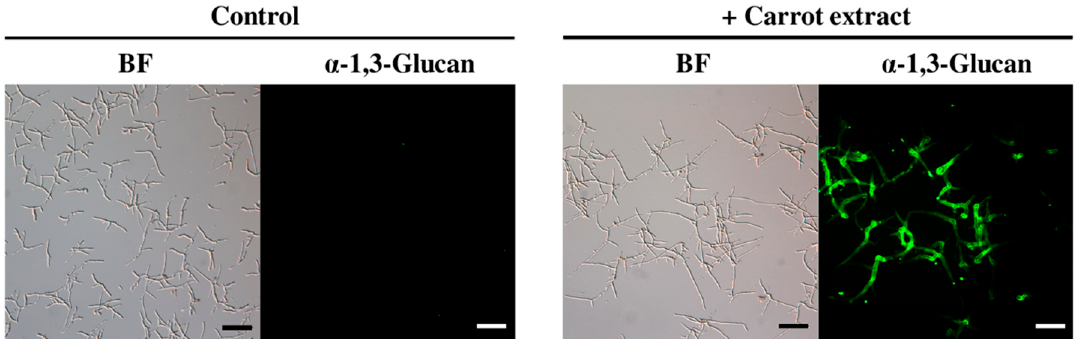
Figure 1. Immunofluorescent detection of α -1,3-glucan on the cell wall of Colletotrichum fioriniae . α -1,3-glucan was clearly visible on the cell wall of the fungi incubated in 0.24% potato dextrose broth (PDB) containing carrot extract (in 1% ethanol and 0.1% dimethyl sulfoxide (DMSO)). The 0.24% PDB solution containing 1% ethanol and 0.1% DMSO was used as a control. BF ( left panels ), bright field microscopy; “ α -1,3-glucan” ( right panels ), fluorescence microscopy. Scale bar, 20 μ m. More than 300 germinated fungal conidia were observed; representative images are shown. Experiments were repeated three times.